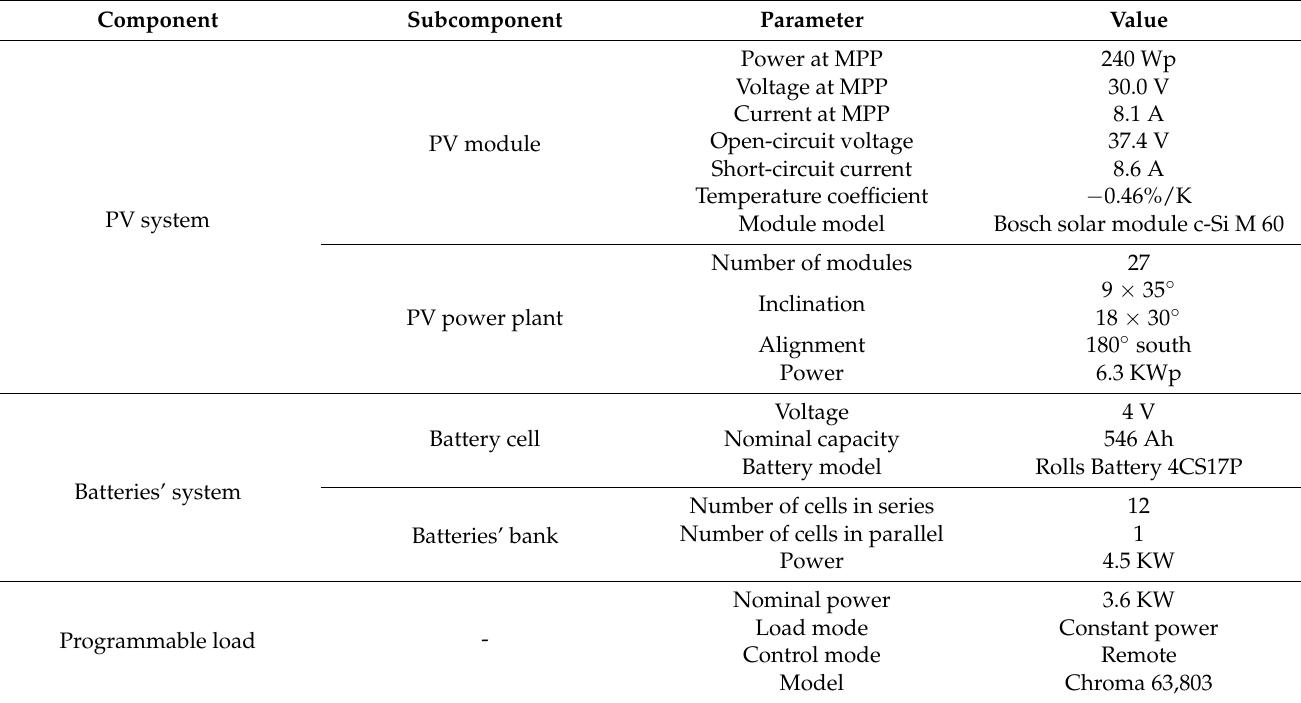
Table 1. Hybrid System